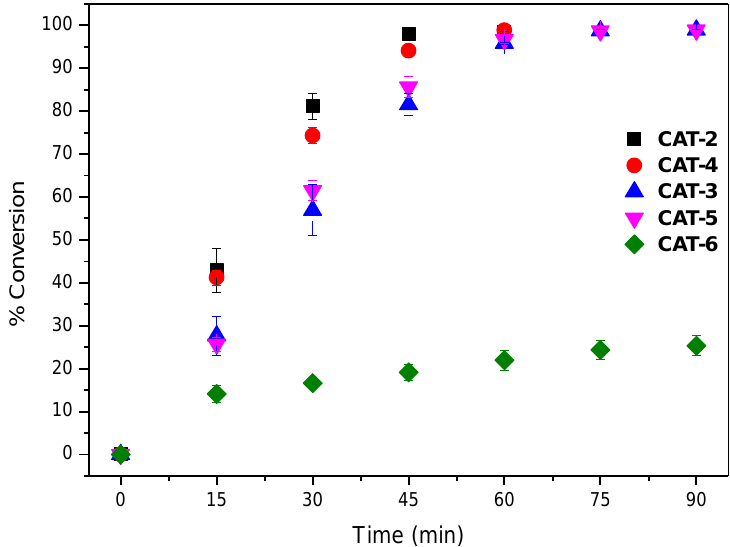
Figure 9. Cyclooctene conversion in the oxidation reactions catalysed by different Mn(III) porphyrin catalysts vs. time for a S/C molar ratio of 150. Data correspond to mean values of at least three non-simultaneous replicates and the vertical bars correspond to the standard deviations.